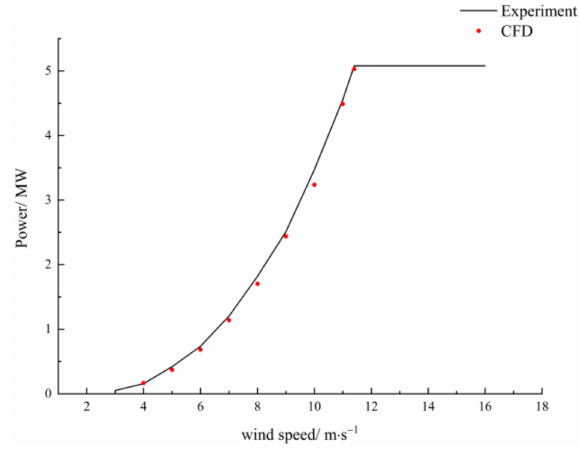
Figure 4. Power comparison of different wind speeds.